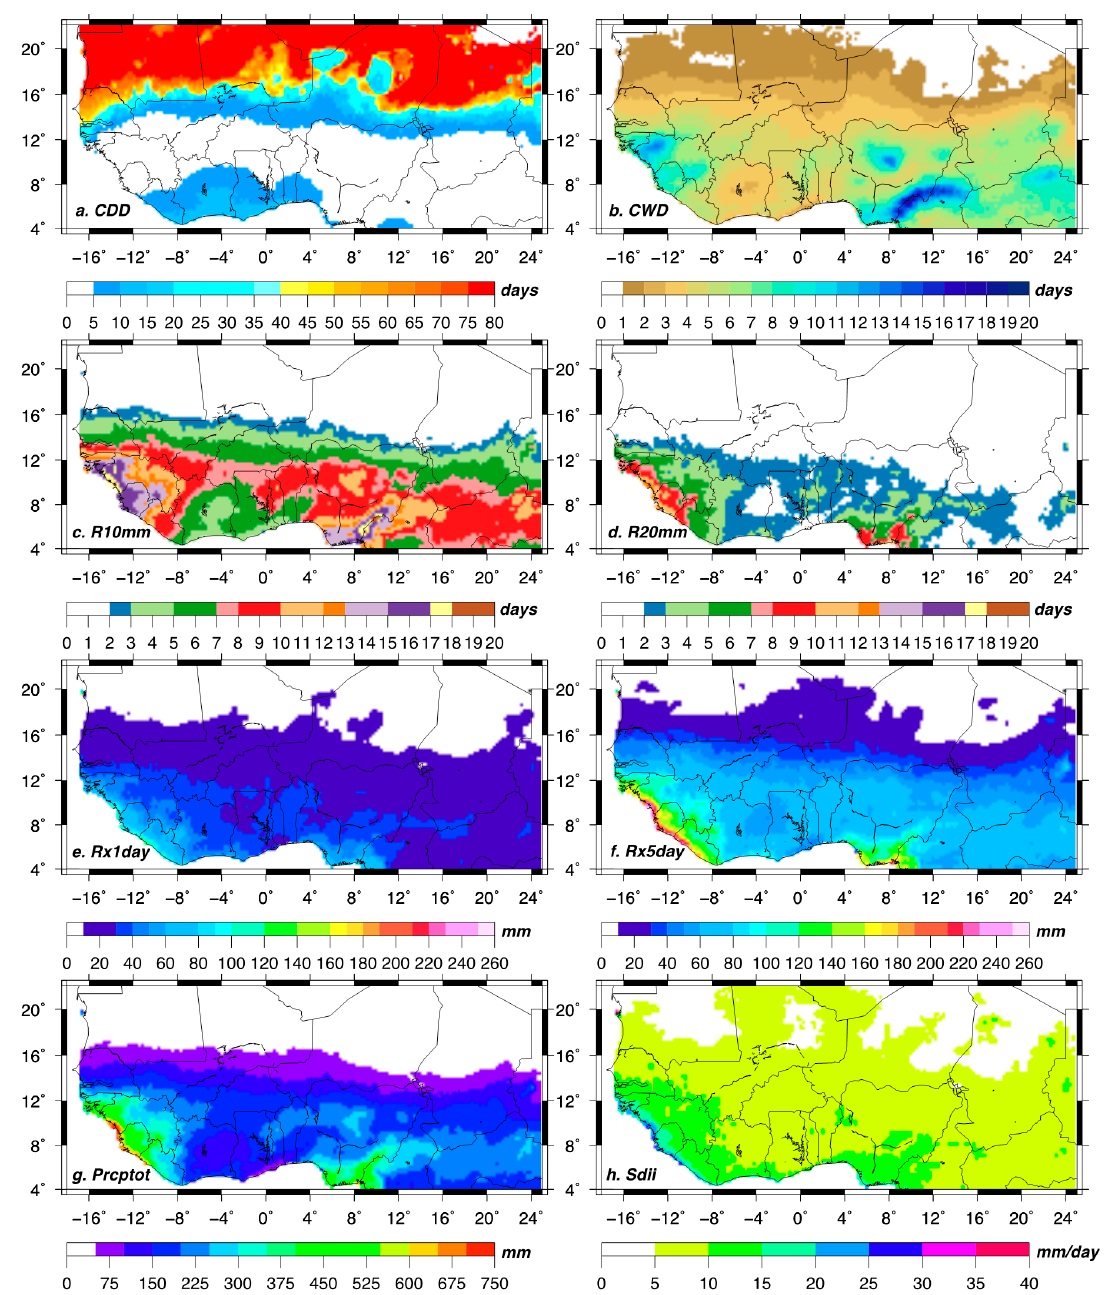
Figure 1. Mean seasonal variability of extreme precipitation indices over West Africa. ( a ) CDD, ( b ) CWD, ( c ) R10mm, ( d ) R20mm, ( e ) Rx1day, ( f ) Rx5day, ( g ) Prcptot and ( h ) Sdii.